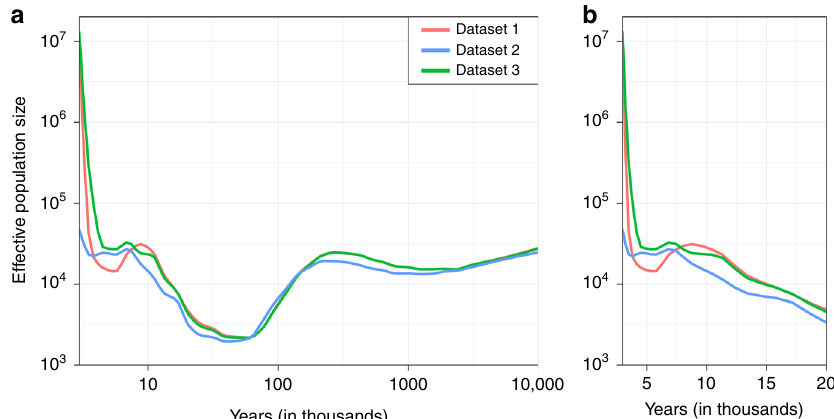
Fig. 2 Longitudinal change of the effective population size of the Japanese population. Longitudinal change of the effective population size of the Japanese population estimated from the WGS data. The effective population sizes were estimated separately for the datasets 1 – 3, using SMC ++ software 20 . Times are indicated in a logarithm and in b linear scales. One generation was considered to be 29 years